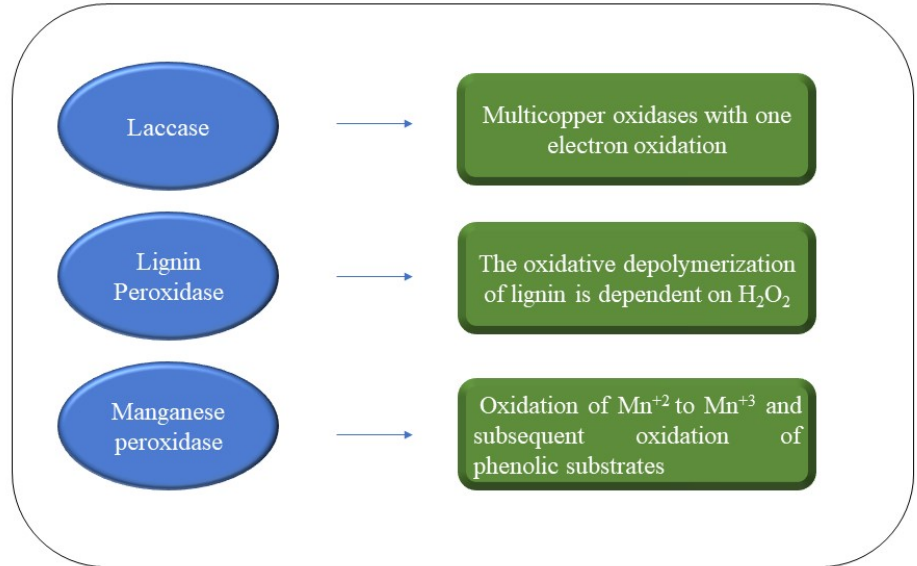
Figure 10. Oxidation mechanism of various lignolytic enzymes.